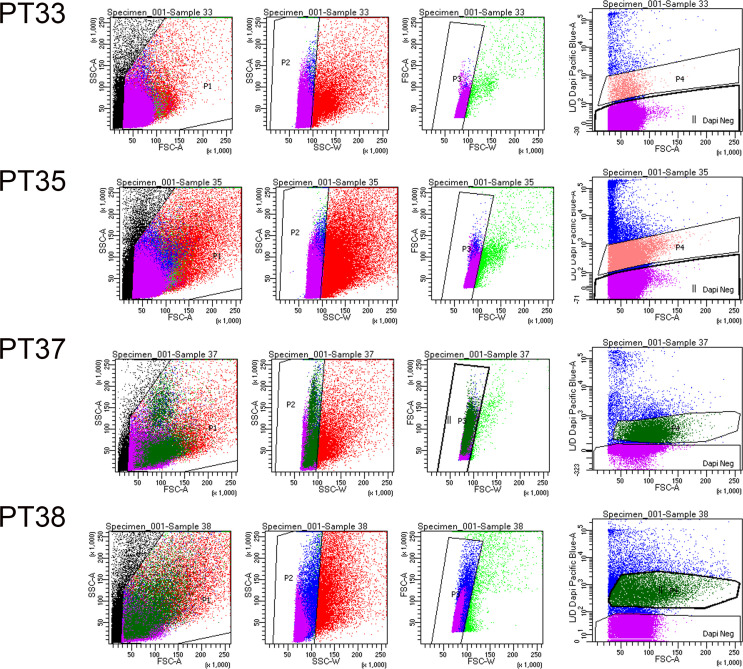
Flow Cytometry Gating Strategies on Human Gingival Cells.Cells were gated based on size using standard SSC-A and FSC-A parameters. Doublets were excluded using SSC-A and SSC-W parameters. Live cells were selected as cells dimly fluorescing in DAPI. Samples were analysed on BD FACS Aria III Fusion machine.